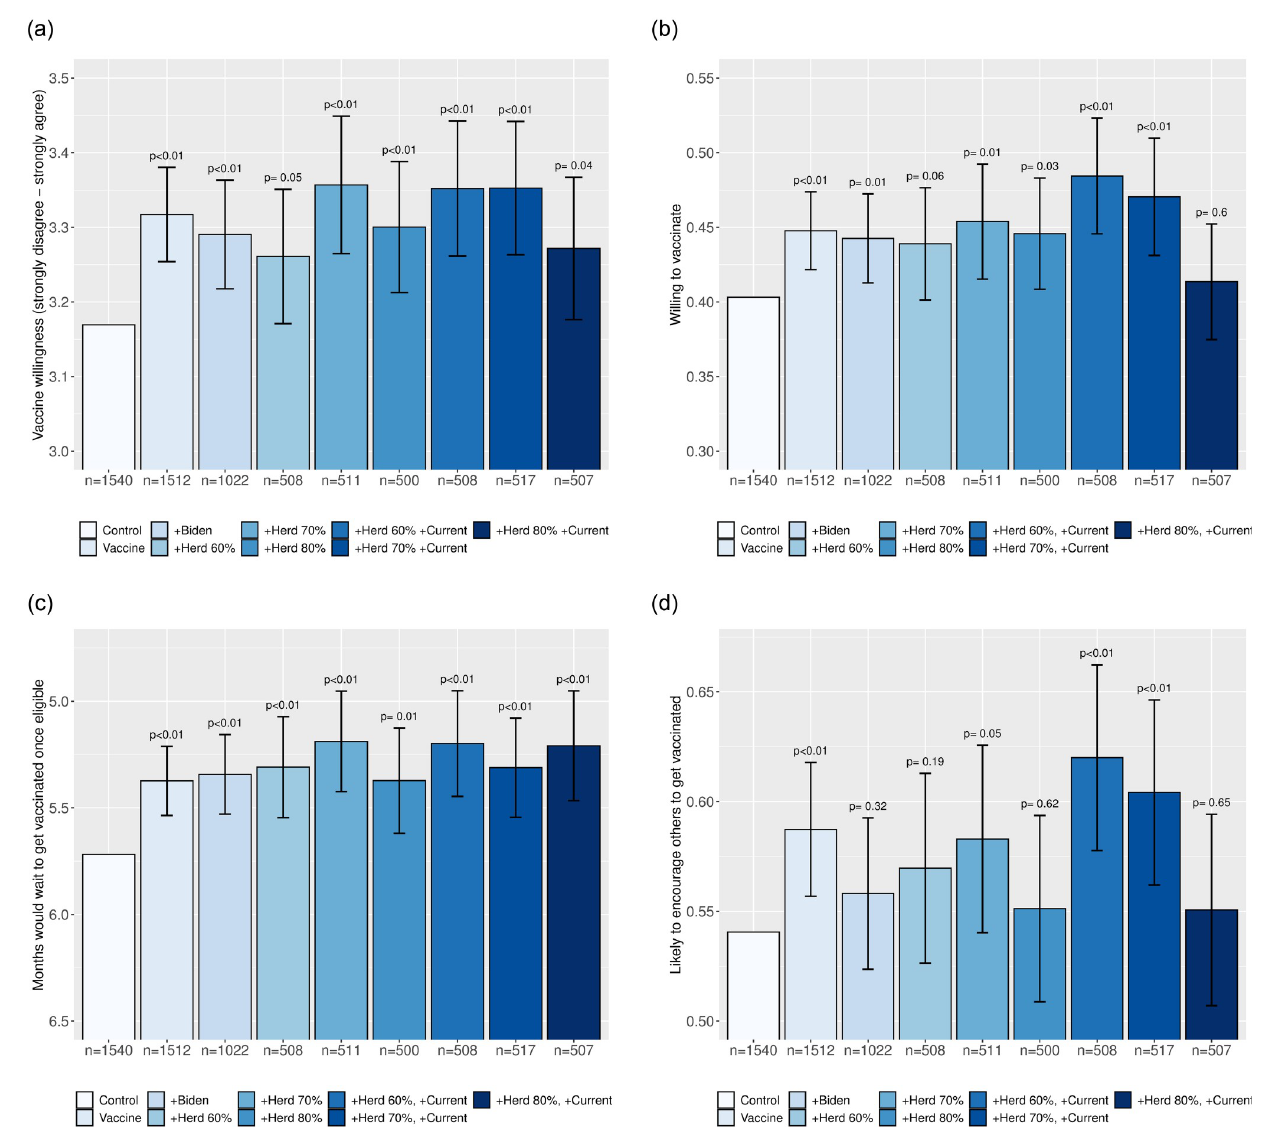
Fig 5. Average effects of vaccine information variants on vaccine willingness. Each bar depicts a group outcome mean, with the sample size in each group reported below. The outcome in panel (a) is a five-point vaccine willingness scale ranging from “strongly disagree” (1) to “strongly agree” (5); the outcome in panel (b) is an indicator for “agree” or “strongly agree”; the outcome in panel (c) is the (reversed) number of months that a respondent would wait to get vaccinated once eligible for a vaccine; and the outcome in panel (d) is an indicator for a respondent being “somewhat likely” or “very likely” to encourage others to get vaccinated. Error bars denote 95% confidence intervals for treatment effects relative to the control group; the associated p values are from two-sided t tests. The underlying regression specifications for each outcome are described in S3 Appendix and the underlying regression table is reported in S6